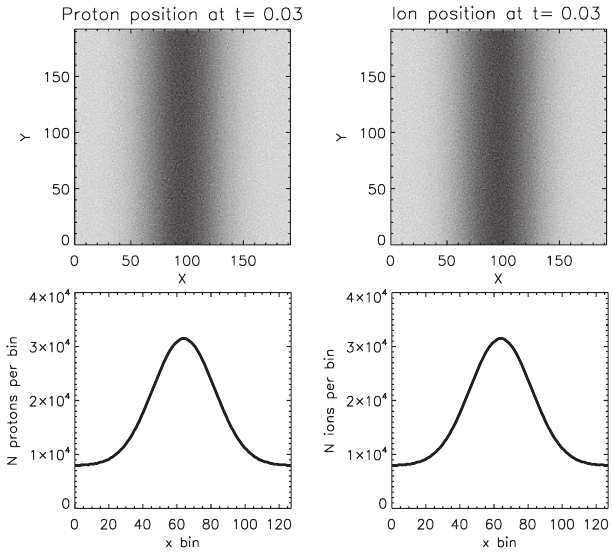
Fig. 1. The initial spatial distributions of protons (left panel) and He ++ ions (right panel) in the inhomogeneous 2-D hybrid